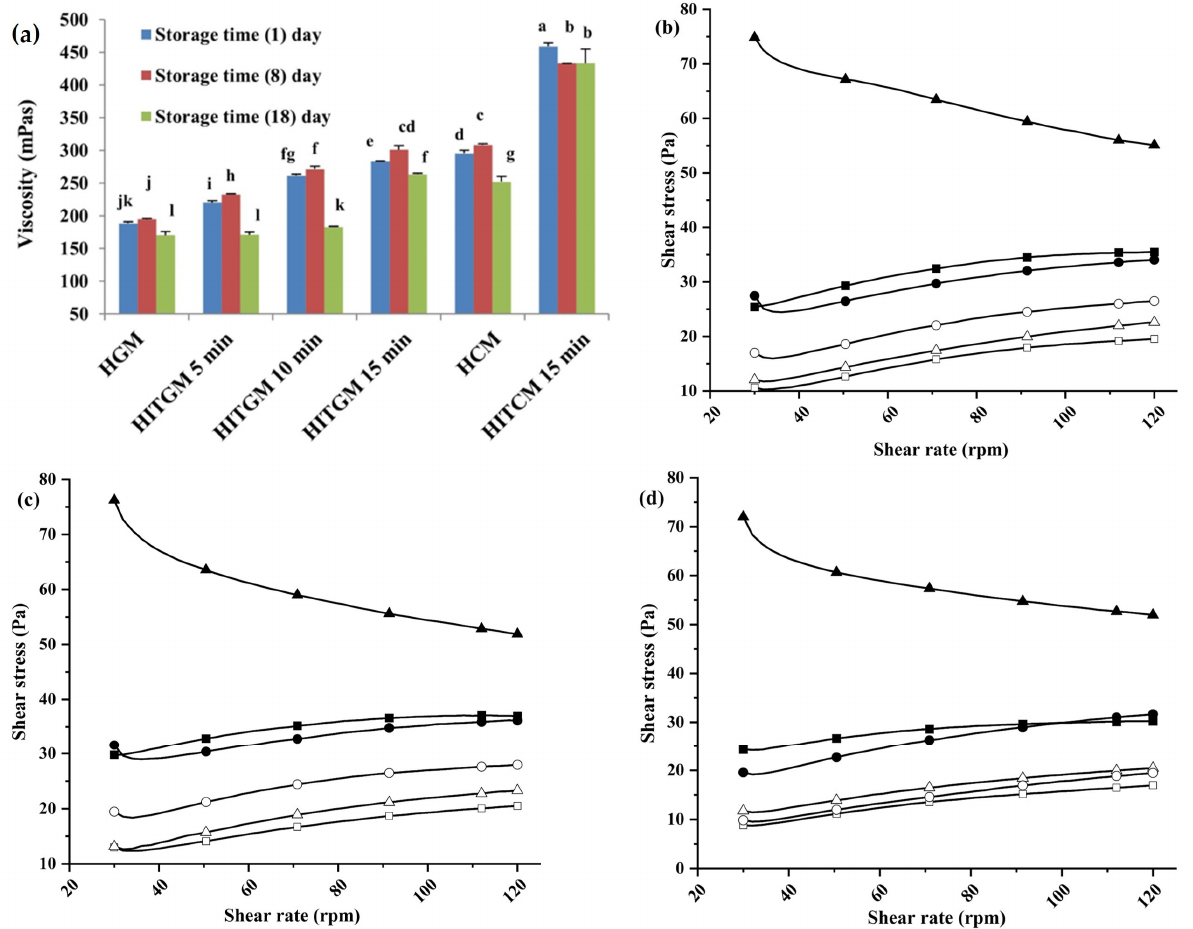
Figure 2. The changes in the viscosity during the storage ( a ) and shear stress of the stirred yoghurt samples during storage for 1 day ( b ), 8 days ( c ) and 18 days ( d ). The symbols represent for the stirred yoghurt from homogenized goat milk, from goat milk, high-intensity thermosonicated for 5 min, from goat milk, high-intensity thermosonicated for 10 min, from goat milk, high-intensity thermosonicated for 15 min, homogenized cow milk and from cow milk, high-intensity thermosonicated for 15 min. Different letters indicate statistical significance within the same column.